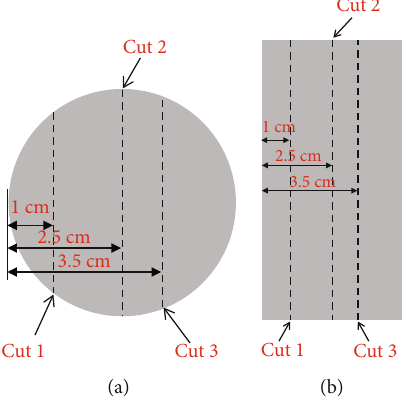
Figure 9: Locations of the cuttings: (a) cross-section; (b) longitudinal